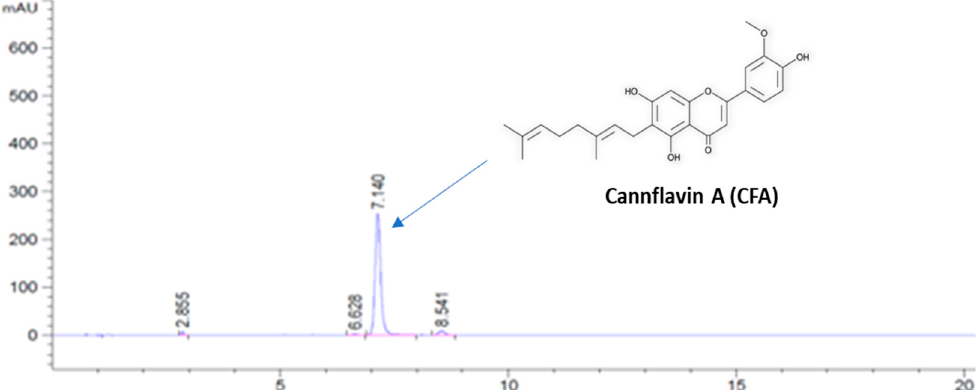
Figure 2. The HPLC chromatographic profile and chemical structure of purified CFA. Chromatography column condition: Sepax GP-C18 column (4.6 × 150 mm, 3 μ m) with a column temperature of 28 °C. Elution method: isocratic solvents system with 70% of aqueous acetonitrile with 0.1% formic acid for 20 min .